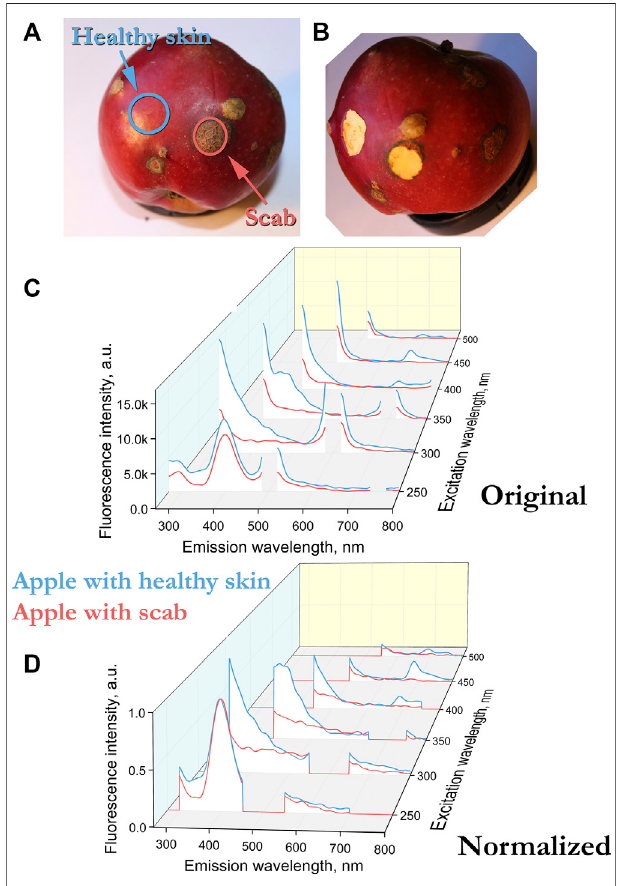
FIGURE 1 | (A) Senator apple with scab infestation. The surface layer was examined and cut off, the cut contour is indicated in the photograph by a solid line. (B) Apple after sampling. (C) Fluorescence spectra of uninfected (blue) and scab-infected (red) surfaces of Senator apples. (D) Normalized peak height at 400 nm (excitation 250 nm) fl uorescence spectra of Senator apples.